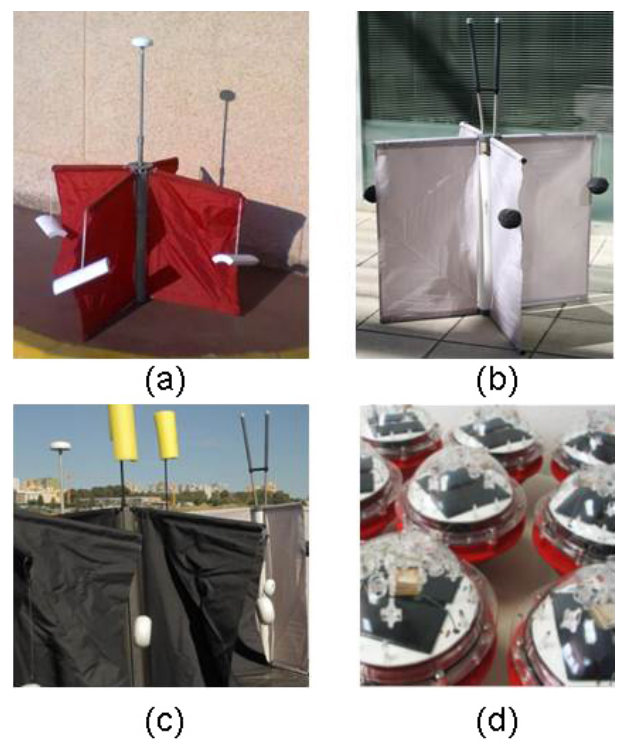
Figure 2. The in situ drifter buoy platforms used in the MEDESS- GIB Campaign: (a) MetOcean I-SLDMB CODE drifter (provided by Puertos del Estado) (b) DBI CODE drifter (provided by ICM- CSIC) (c) . Albatros CODE/Davis drifter (provided by IMEDEA); ODI Sphere drifter (provided by IMEDEA).